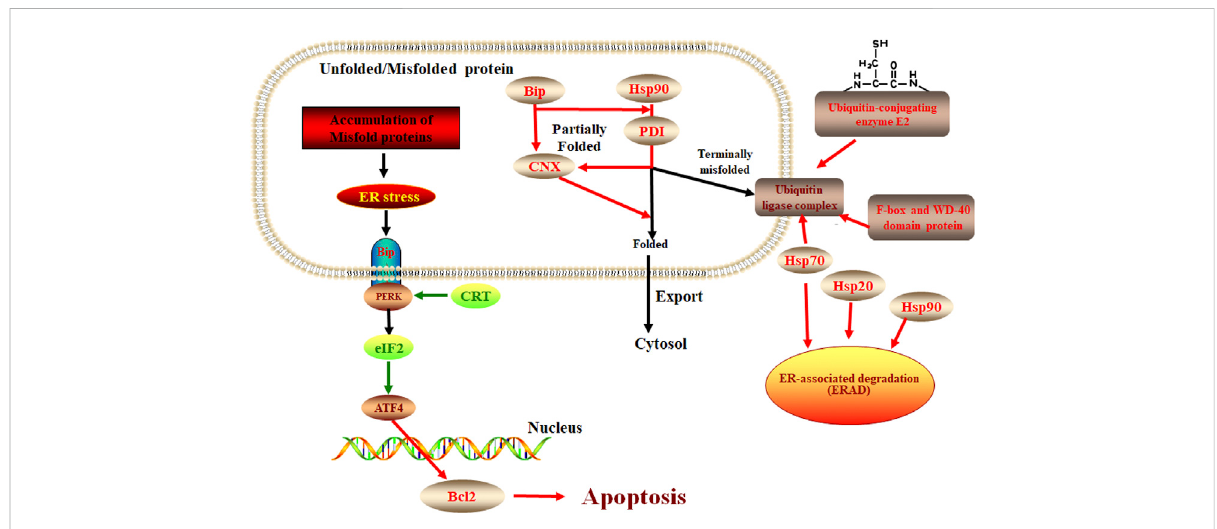
The protein processing in the ER pathway in E. ulmoide response to F. oxysporum . Red color represents up-accumulated genes or proteins in this pathway, while the green color represents